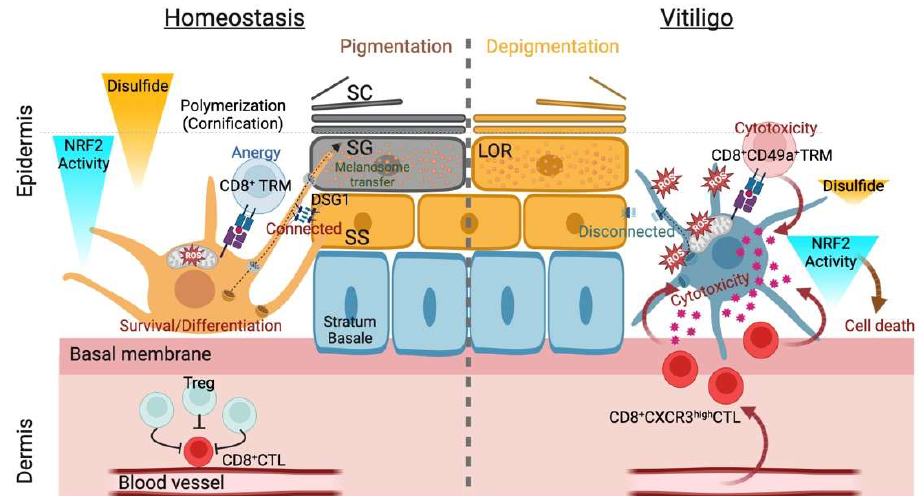
Figure 2. Summary of thiols/disulfides in the epidermal pigmentary system. Interfollicular epider- mis (IFE) pigmentation largely depends on the balance between reduction and oxidation (redox) status with internal or external causes. The former refers to mitochondria-derived reactive oxygen species (ROS) during melanogenesis, and the latter may correspond to epidermal differentiation in which keratinocyte (KC) structural proteins undergo extensive disulfide bridge formation upon the initiation of cornification (transition from the stratum granulosum [SG] to the stratum corneum [SC]). Successful cornification largely depends on the biochemical nature of the structural protein loricrin (LOR, indicated as granules). Differentiating layer (stratum spinosum [SS] and SG)-specific desmosomal cadherin desmoglein 1 (DSG1) appears indispensable for functional IFE pigmentogenesis: melanosome transfer and maturation (eumelanogenesis) (left). In vitiligo melanocytes, stress from environmental factors (e.g., toxic chemicals) can cause aberrations in the IFE antioxidant systems in genetically predisposed individuals. Breached immune tolerance recruits melanocyte anti- gen-specific CD8 + cytotoxic T cells (CTLs) expressing CXC receptor type 3 (CXCR3) or CD49 + resi- dent memory T cells (TRMs) in vitiligo (right), whereas the autoreactive CTLs constitutively become anergic with the help of regulatory T cells (Tregs) in homeostasis (left). The homeostatic gradient of nuclear factor erythroid-2-related factor 2 (NRF2)-mediated epidermal antioxidative defense and ensuing cornification yield a polymerized/pigmented SC, protecting against oxidative damage. However, local clonal expansion of CTLs in the IFE eventually eliminates melanocytes from the IFE niche (the epidermal melanin unit), perturbing the xenobiotic metabolism coordinated by NRF2 and resulting in depigmentation (leukoderma).